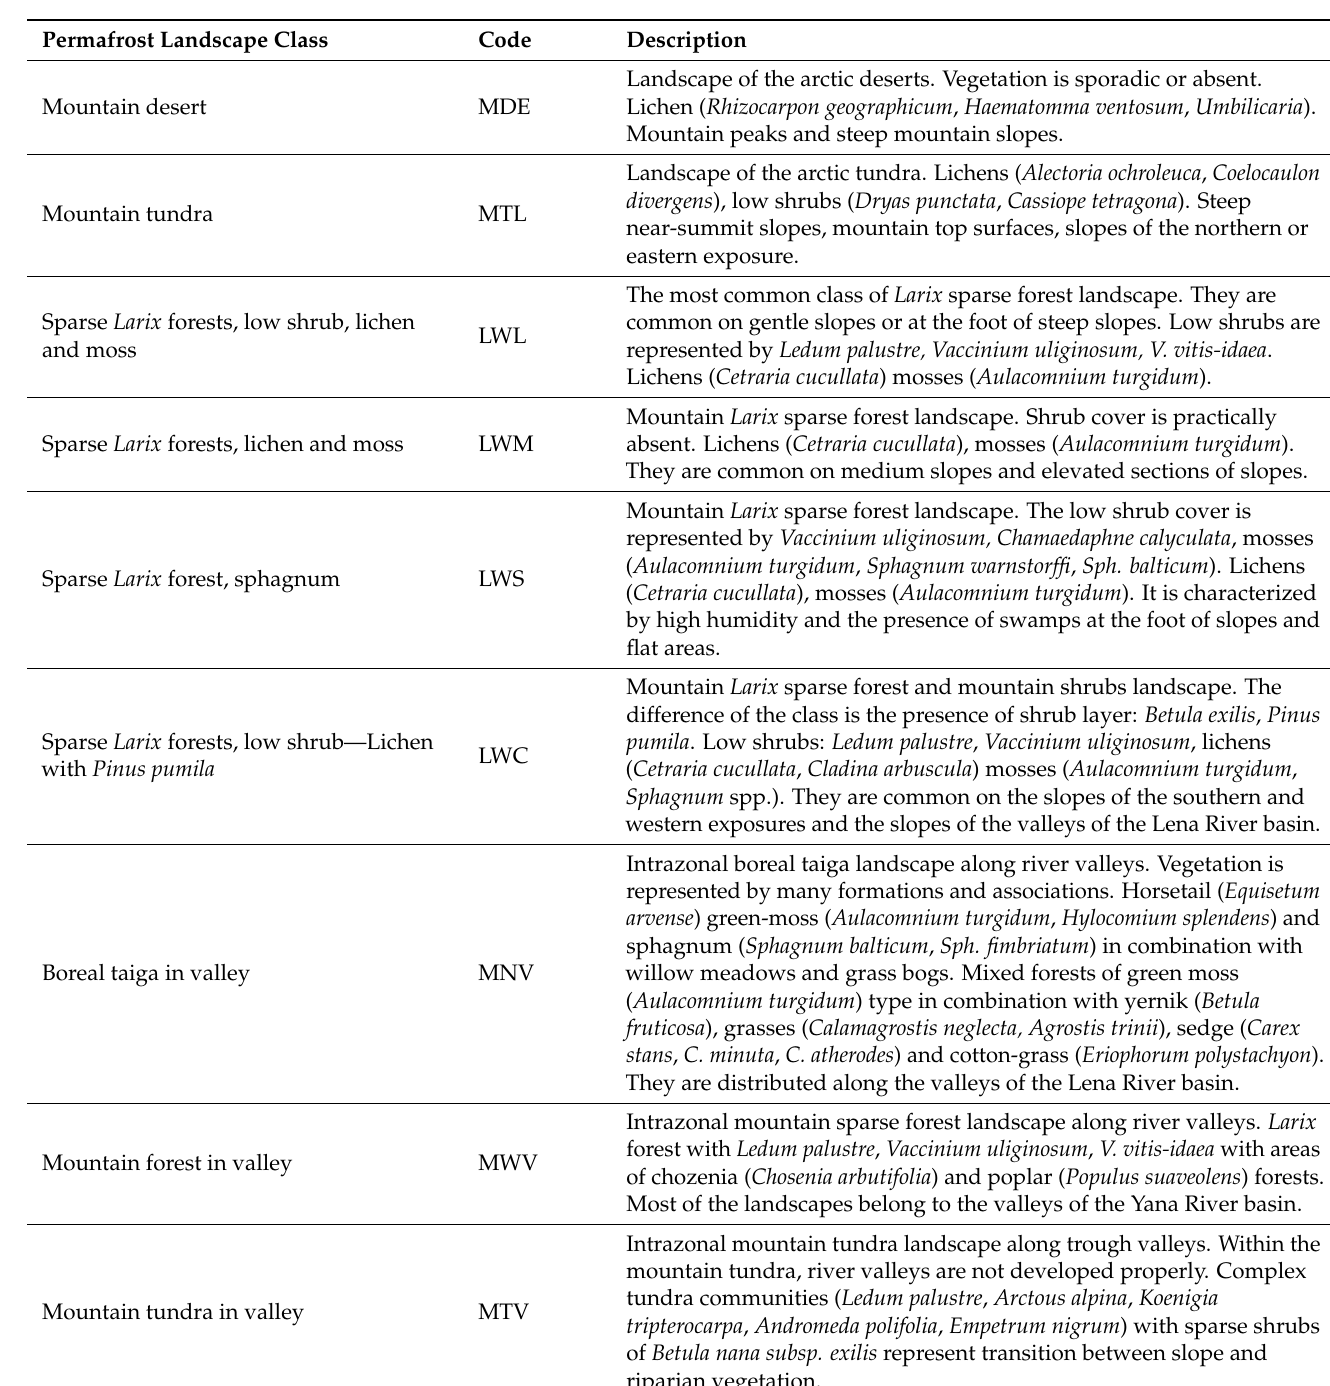
Table 5. Classification and description of permafrost landscape classes of the Orulgan